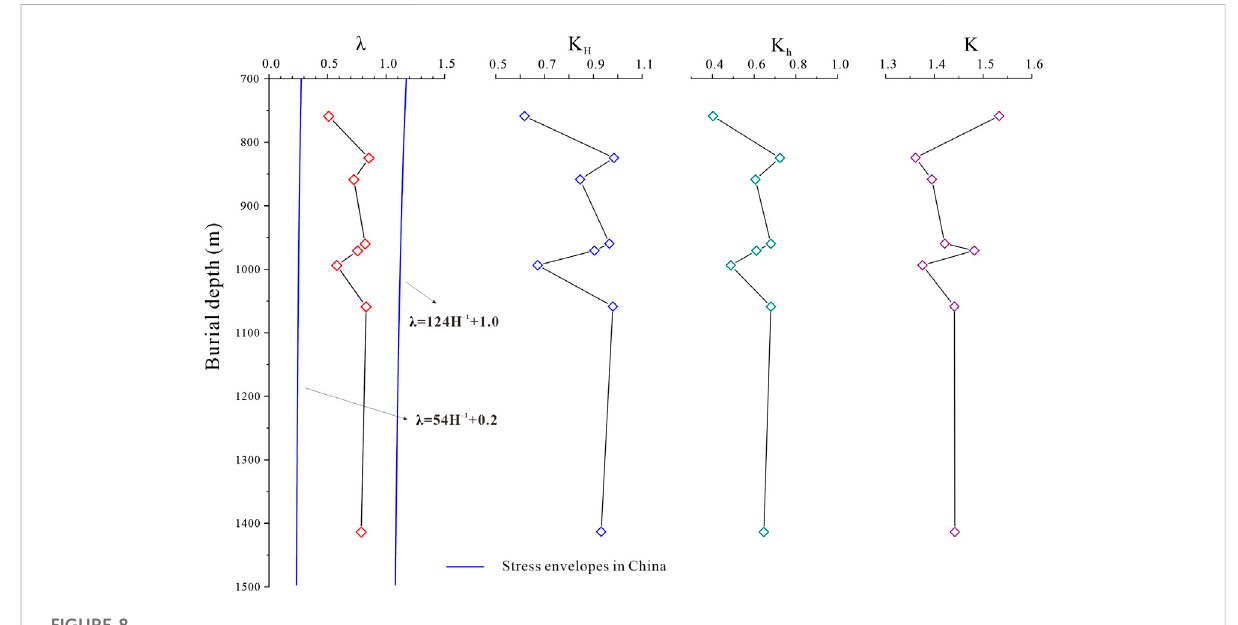
FIGURE 8 Variation of principal stress ratios with